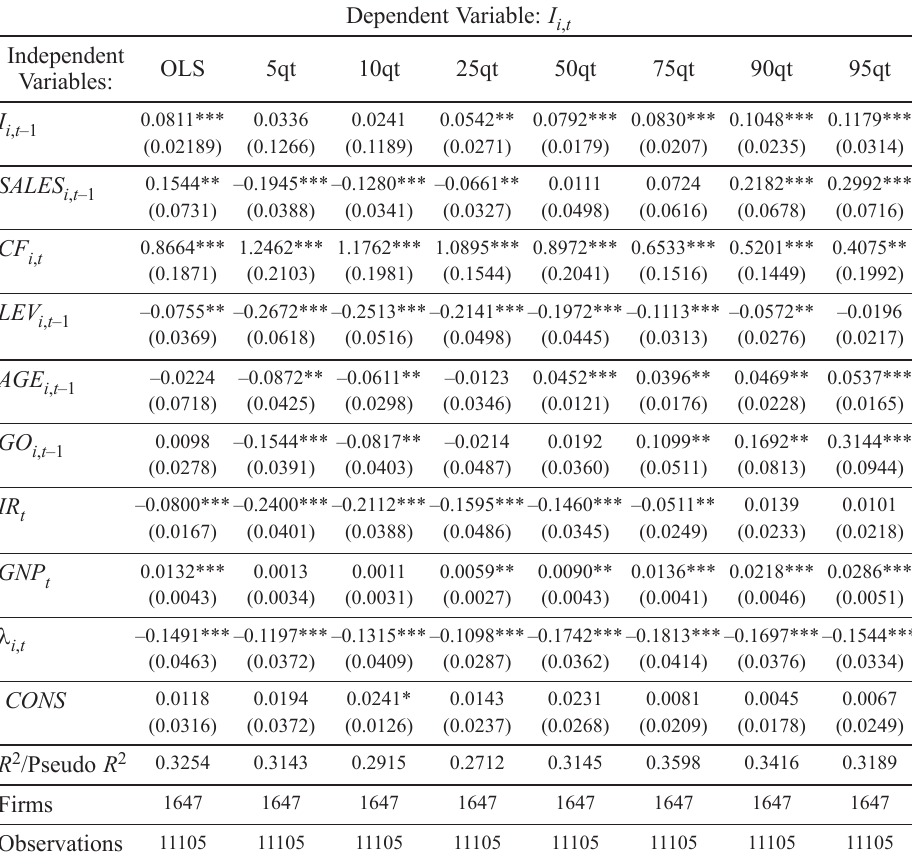
Table 5. Investment determinants